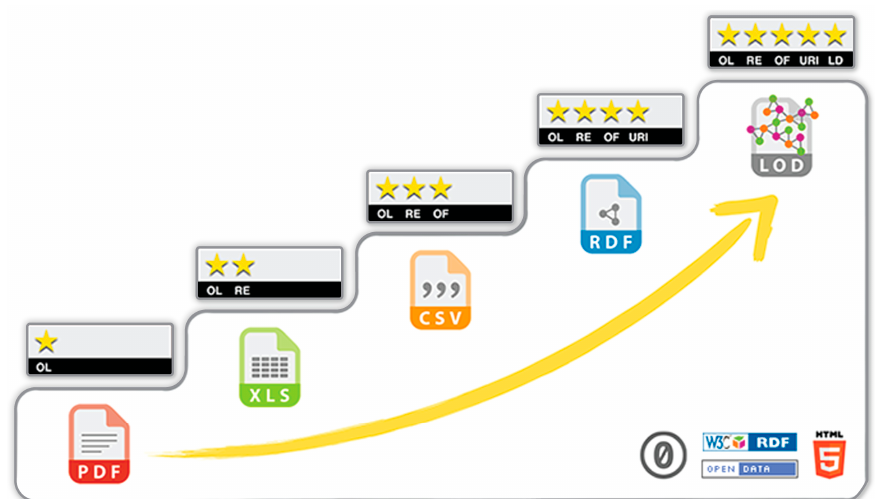
Figure 1. The five-star deployment scheme for open data. A handwritten document published on